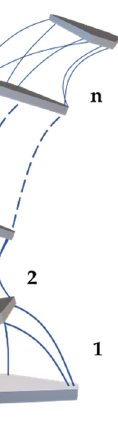
Figure 7. Series-parallel robot and n parallel